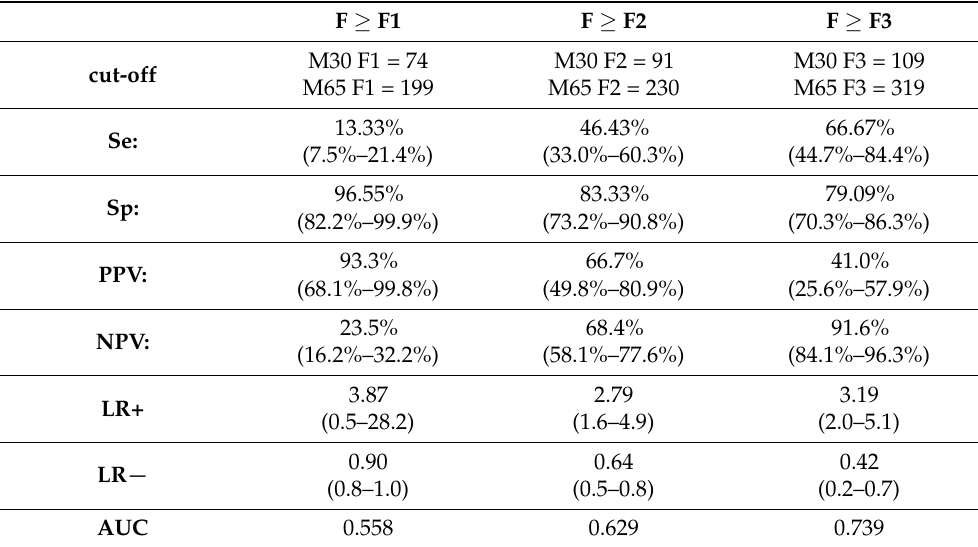
Table 6. Diagnostic performance of the M30 and M65 combination for fibrosis grades greater than or equal to 1, greater than or equal to 2, and greater than or equal to